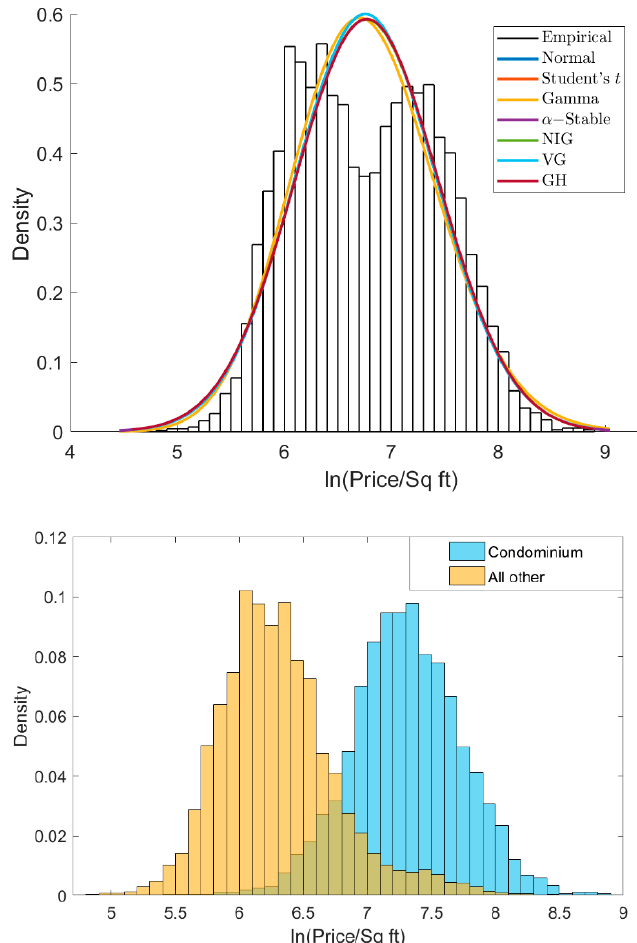
Figure 3. ( top ) The distribution of ln(Price/Area) for ( top ) all property types in NYC and ( bottom ) condominiums plotted separately from the remaining three property types.